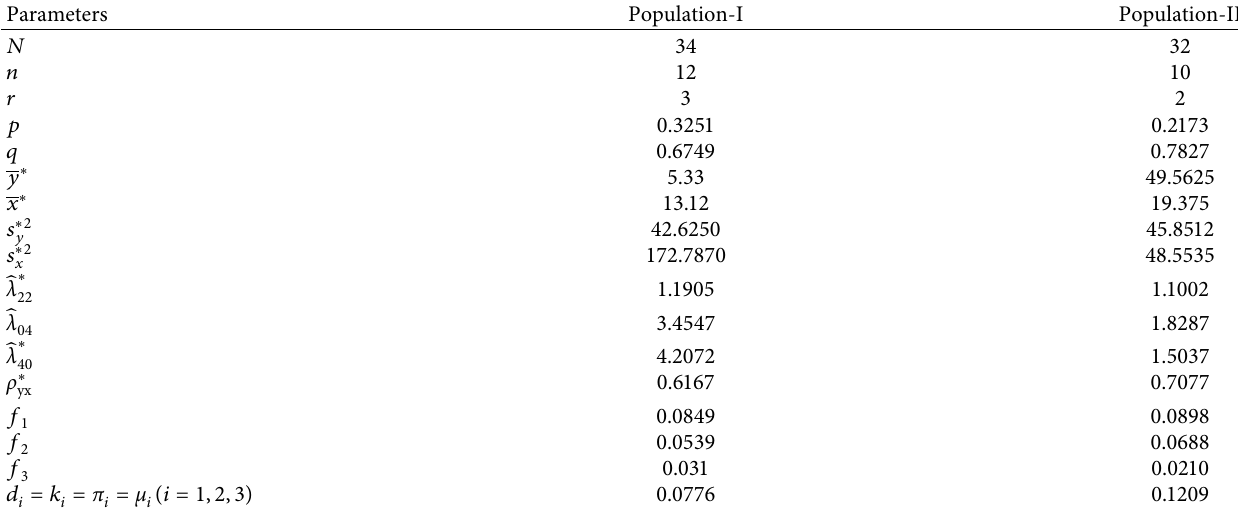
Table 2: Data summary for population-I and